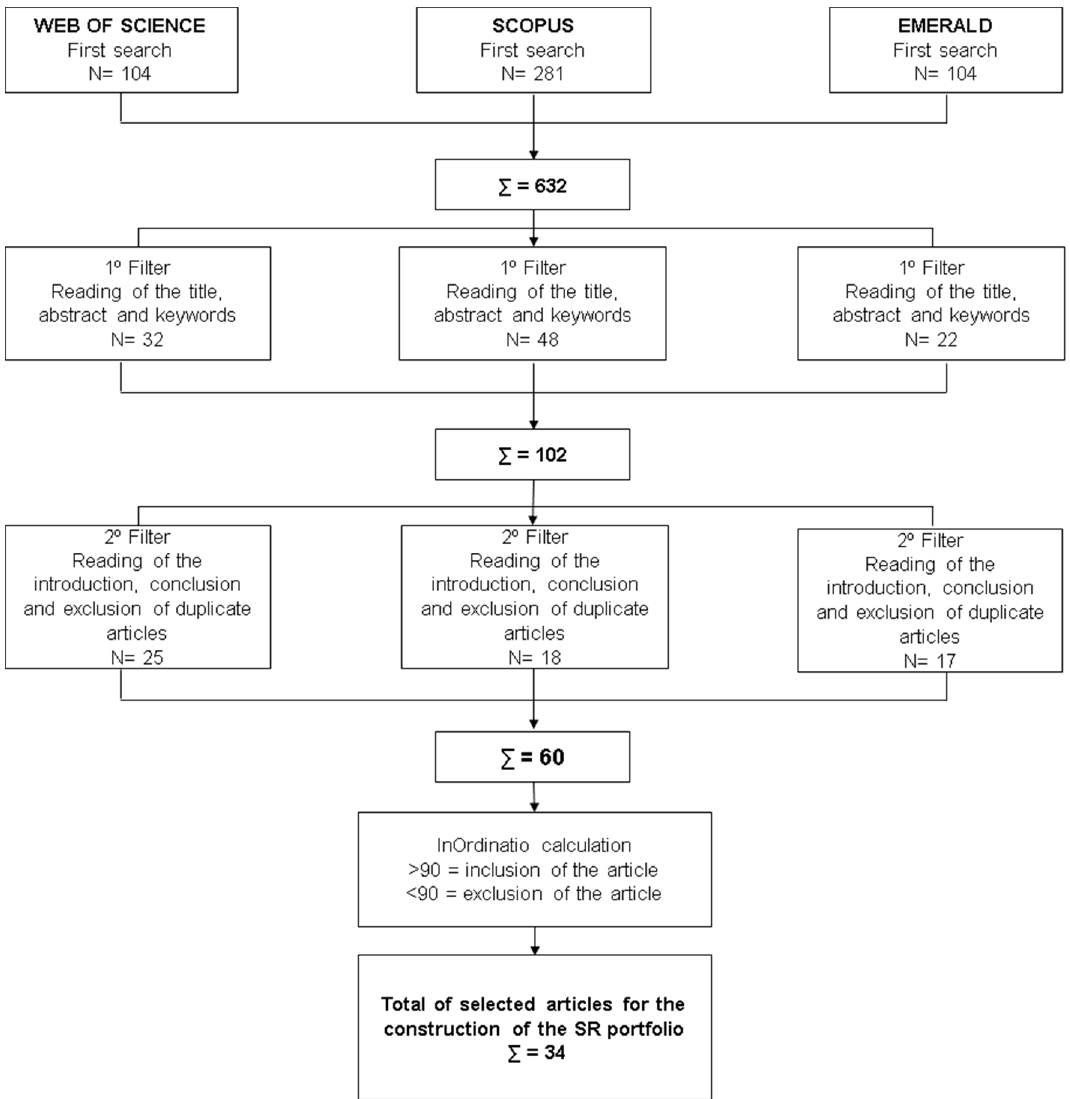
Figure 2. Filter Results of the systematic review of the literature.